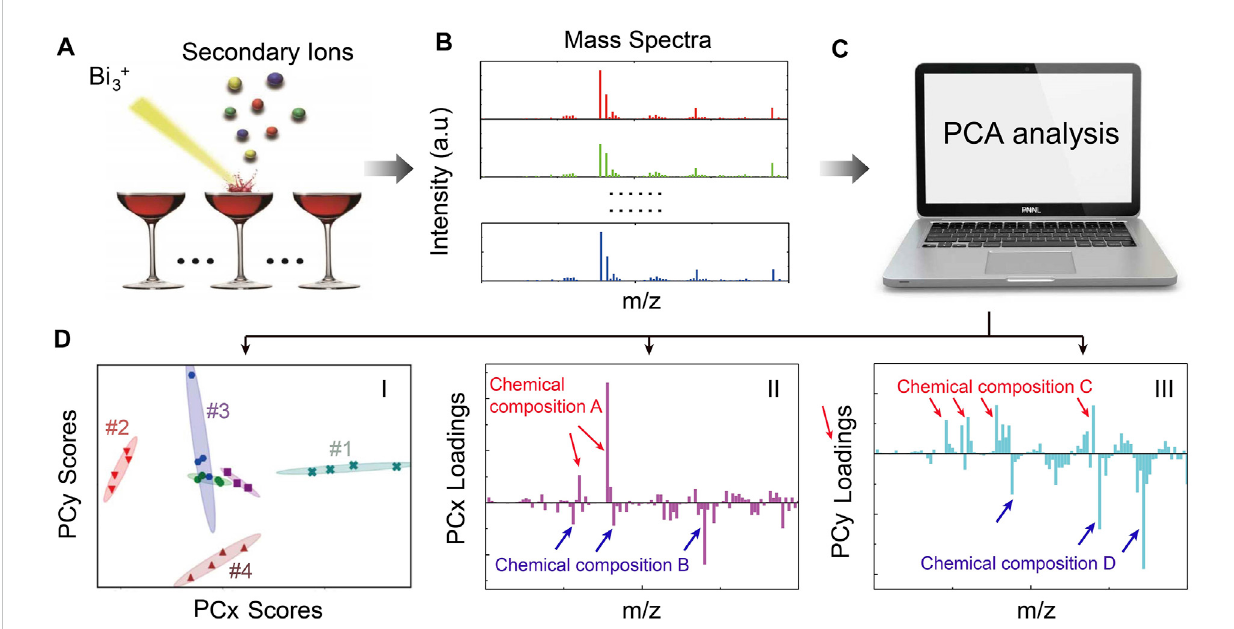
FIGURE 1 Aschematicillustrationoftheprincipleof insitu liquidSIMSandPCAanalysisofwines. (A) ABi 3 + primaryionbeamisusedtogeneratesecondaryions fromthewinesurface. (B) SIMSspectraareobtainedfromdifferentwines. (C) PCAanalysisisperformedusingacomputer.AfterPCAanalysis,scoresplots [e.g., (D – I ) ], and corresponding loadings plots [e.g., (D-II) and (D-III)] can be obtained simultaneously. The scores plot is used to visualize differences among wines and data repeatability, while the loadings plots can provide details of chemical differences among